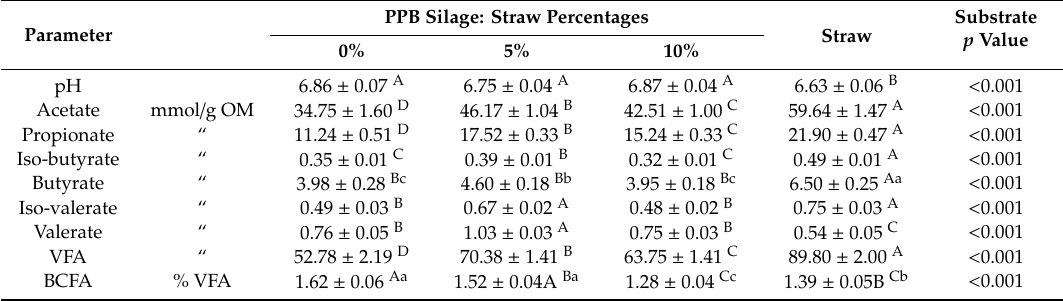
Table 3. PH and in vitro fermentation end-products after 120 h of incubation of PPB silages and wheat straw.